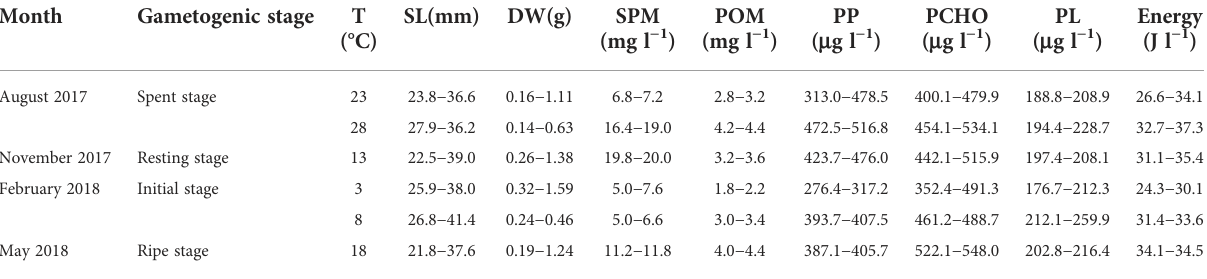
TABLE 1 Shell length (SL) and dry tissue weight (DW) of experimental individuals, and composition of suspended particulate matter (SPM) supplied to the ark shell Anadara kagoshimensis .